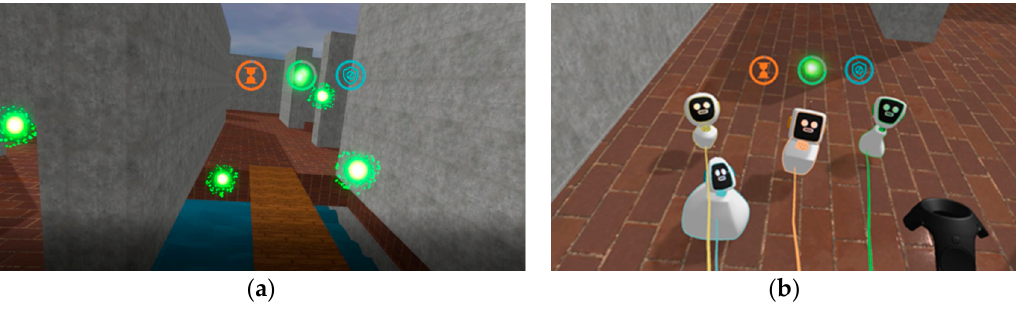
Figure 1. ( a ) AEMIN maze; ( b ) Avatars.